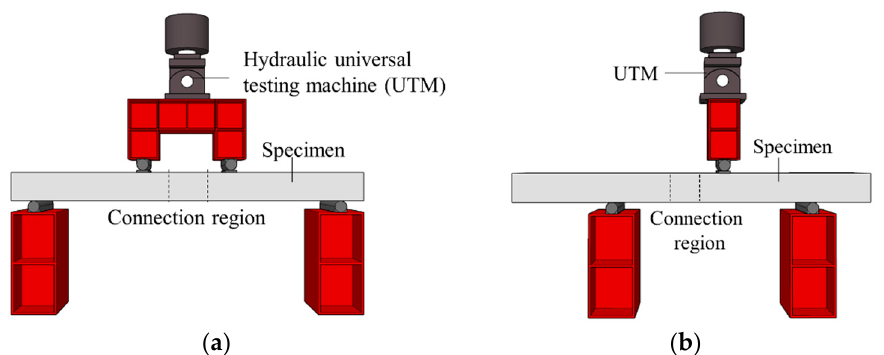
Figure 7. Test setup: ( a ) schematic of the test setup for flexural test; ( b ) schematic of the test setup for shear test.